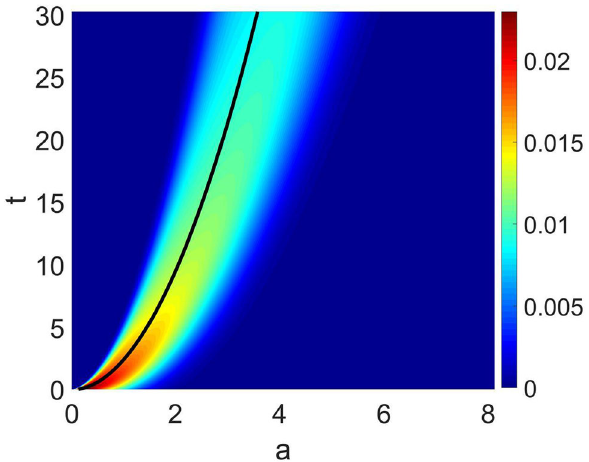
Fig. 1 Variations in the probability distribution of the scale factor. The horizontal and vertical axes represent the scale factor and time variable, respectively. The black curve is the classical trajectory of the universe drivenbyheatradiation.Theparametersaretakenas: p a = 10, α = 0 . 5, V 0 = 200